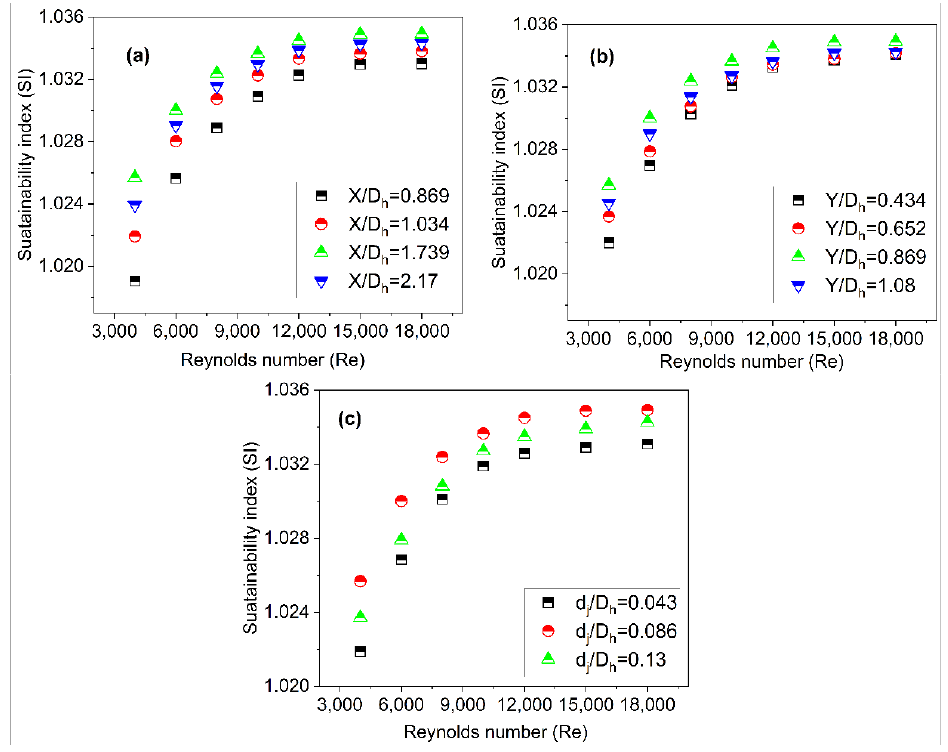
Figure 17. Effect of ( a ) X/D h , ( b ) Y/D h and ( c ) d j /D h on SI . The waste energy ratio ( (cid:127)Q(cid:8) ) represents the exergy loss per unit of exergy available at an inlet. The exergy loss decreases significantly with an increase in the Reynolds num- ber. The decrement in exergy loss signifies that the energy available at the inlet is used for the heating process. As the usage of exergy increases, the (cid:127)Q(cid:8) values decrease, as can be seen in the Figure 18. The (cid:127)Q(cid:8) varies between 0.9665–0.9832, 0.962–0.9832 and 0.97– 0.9832 according to varying ((cid:24)/(cid:22) , ( (cid:25)/(cid:22) ) and ( (cid:19) ) values, respectively. At higher (cid:23) ) (cid:23) (cid:20) /(cid:22) (cid:23) values in terms of (cid:8)(cid:9) , a higher heat transfer is received and, hence, the lower the (cid:127)Q(cid:8) . Figure 18a, represents the variation in (cid:127)Q(cid:8) as a function of (cid:8)(cid:9) by varying the (cid:24)/(cid:22) (cid:23) from 0.869 to 2.17. The lowest (cid:127)Q(cid:8) value was obtained at an (cid:24)/(cid:22) , and the max- (cid:23) = 1.739 imum at an (cid:24)/(cid:22) = 0.869. These trends signify that, among the studied parameters, the (cid:23) exergy losses reach a maximum at lower (cid:24)/(cid:22) value and a minimum at higher values (cid:23) until the (cid:24)/(cid:22) reaches 1.739. Beyond an (cid:24)/(cid:22) = 1.739 and for all (cid:8)(cid:9) values, the (cid:127)Q(cid:8) (cid:23) (cid:23) was higher. The apparent reason for this is that at an (cid:24)/(cid:22) = 2.17, the heat transfer de- (cid:23) creases and, hence, the (cid:127)Q(cid:8) increases. Similar trends in terms of (cid:127)Q(cid:8) variations can be seen in Figure 18b, where ((cid:24)/(cid:22) and ( (cid:19) ) are kept constant and the (cid:127)Q(cid:8) results as (cid:23) ) (cid:20) /(cid:22) (cid:23) function of (cid:8)(cid:9) by varying the ( (cid:25)/(cid:22) ) are shown. The results testify that the optimum (cid:23) (cid:25)/(cid:22) (cid:23) value is 0.869, where the (cid:127)Q(cid:8) is at a minimum. The results in terms of (cid:127)Q(cid:8) by varying the ( (cid:19) (cid:20) /(cid:22) (cid:23) ) are shown in Figure 18c, which shows that a (cid:19) (cid:20) /(cid:22) (cid:23) = 0.086 results in a minimum (cid:127)Q(cid:8) .